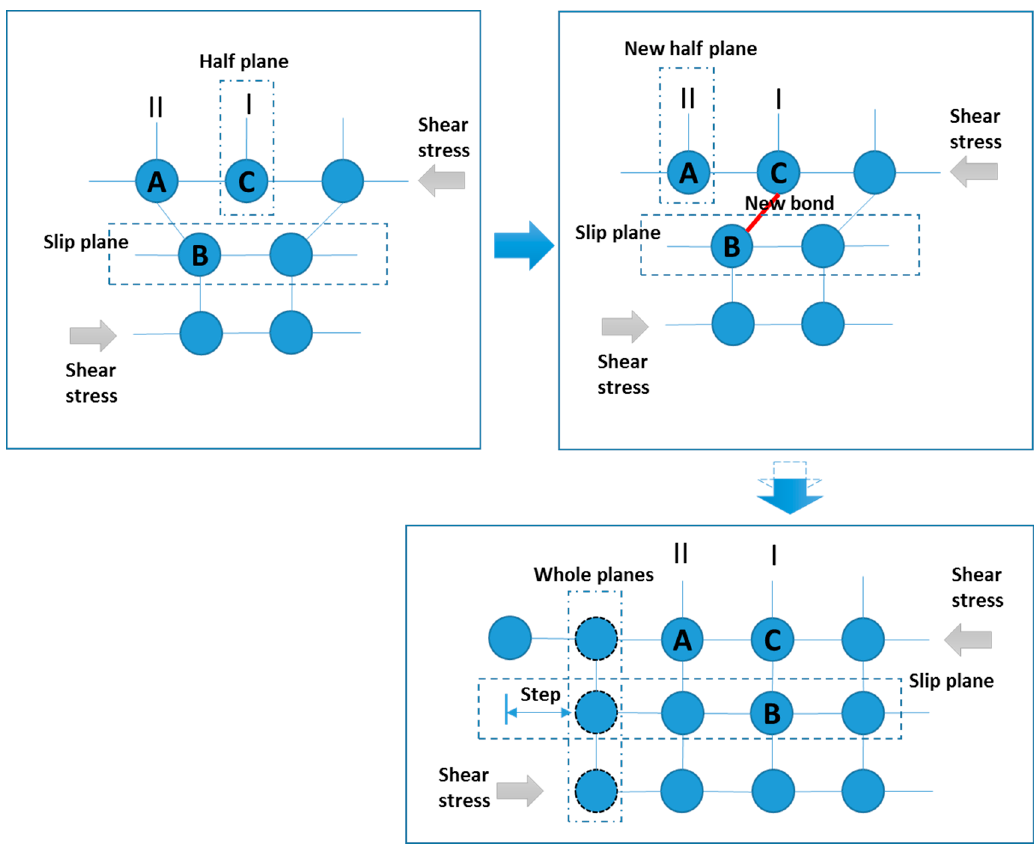
Figure 2. Edge dislocation process.